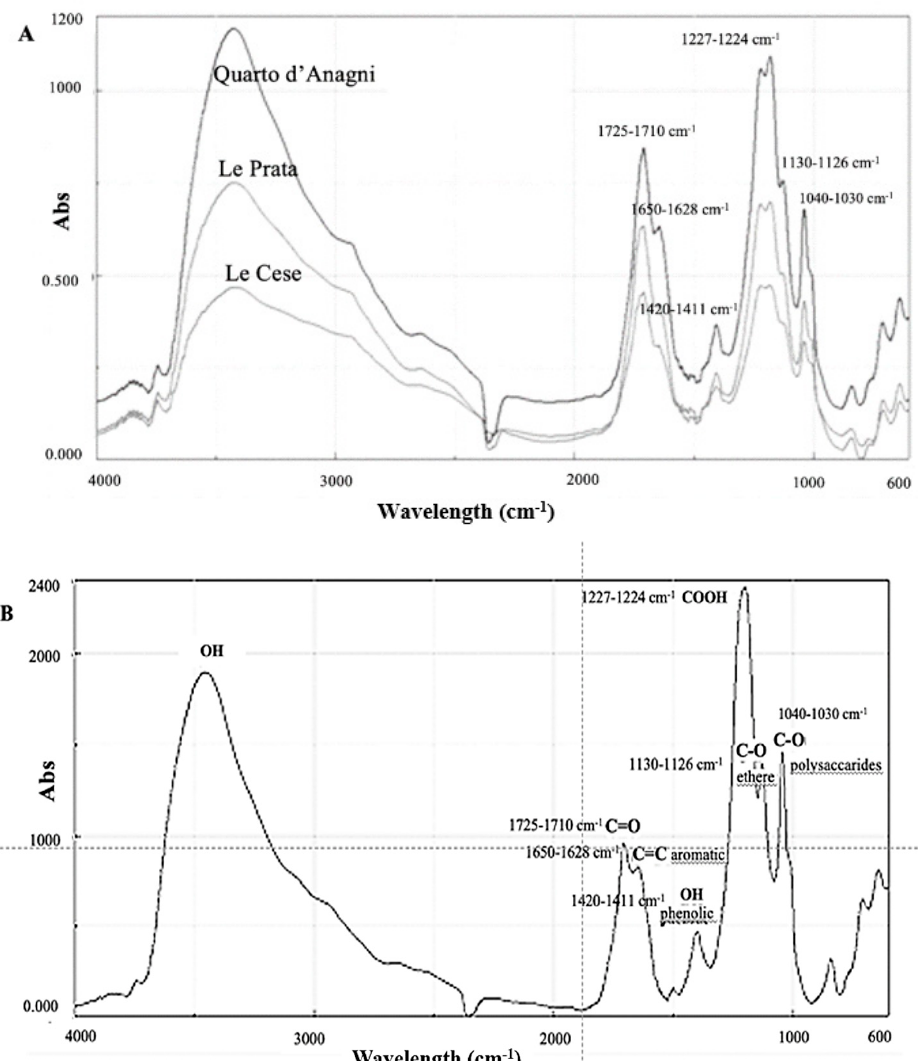
Figure 3. FTIR spectra of fulvic acids extracted from the soil samples of chestnut forests ( A ) and mineral water ( B ).